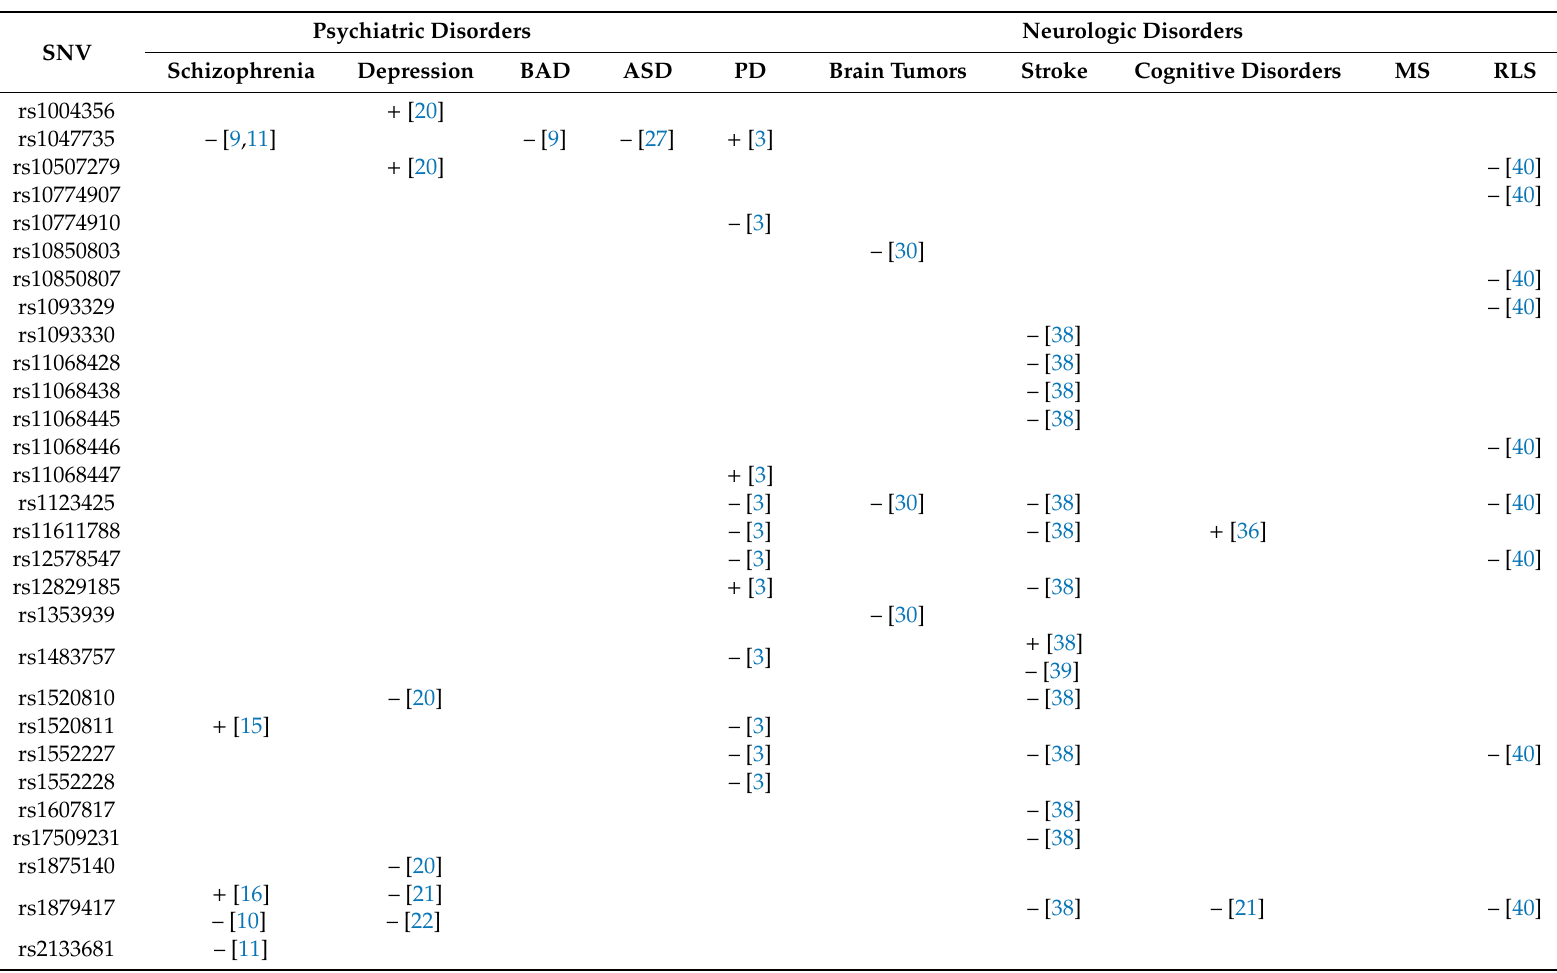
Table 1. Association of NOS1 SNVs with neuropsychiatric disorders. ASD: Autism Spectrum Disorders, BAD: Bipolar A ff ective Disorder, MS: Multiple Sclerosis, PD: Parkinson’s Disease, RLS: Restless Legs Syndrome, SNV: Single Nucleotide